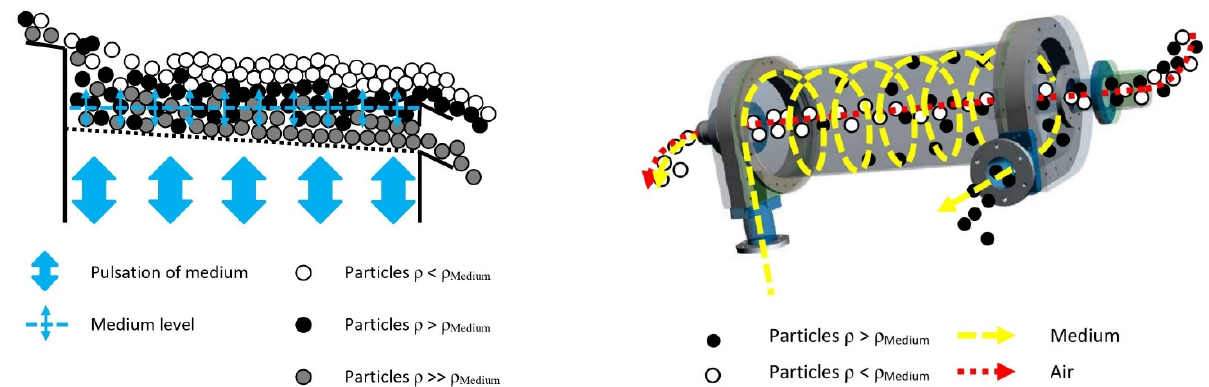
Figure 3. Function principle of the core components: Jig ( left ) and centrifugal force separator [13] ( right ) (Reproduced with permission from Schwabl D.; Proceedings of the tenth “Recycling und Rohstoffe” Conference published by TK-Verlag, Berlin, 2017).